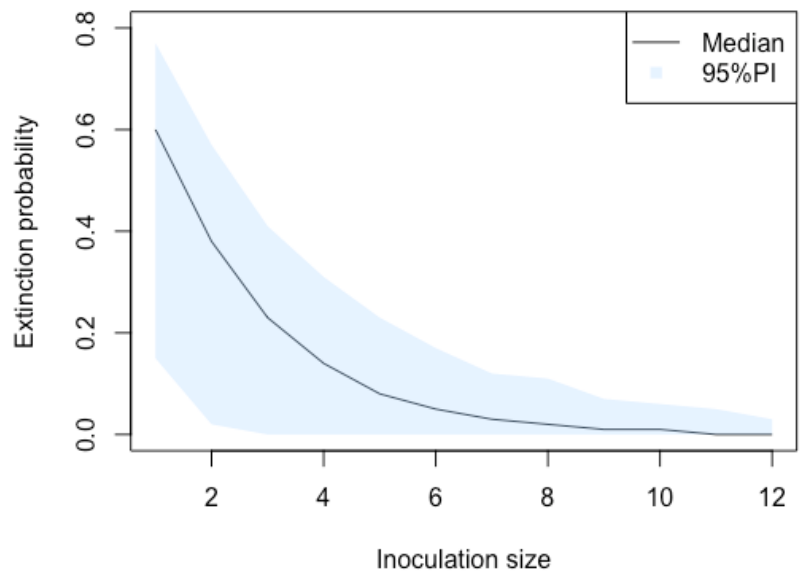
Figure 3. Relationship between extinction probability and inoculation size. We set P init to be a fixed value (between 1 and 12) and the other parameters are selected from the 5000 posterior samples (population mean parameter values) generated by Cao et al. The median (solid line) and 95% PI (blue area) are generated by simulating the stochastic model 100 times to calculate the extinction probability by the proportion of extinction events in the 100 realisations as described in Materials and